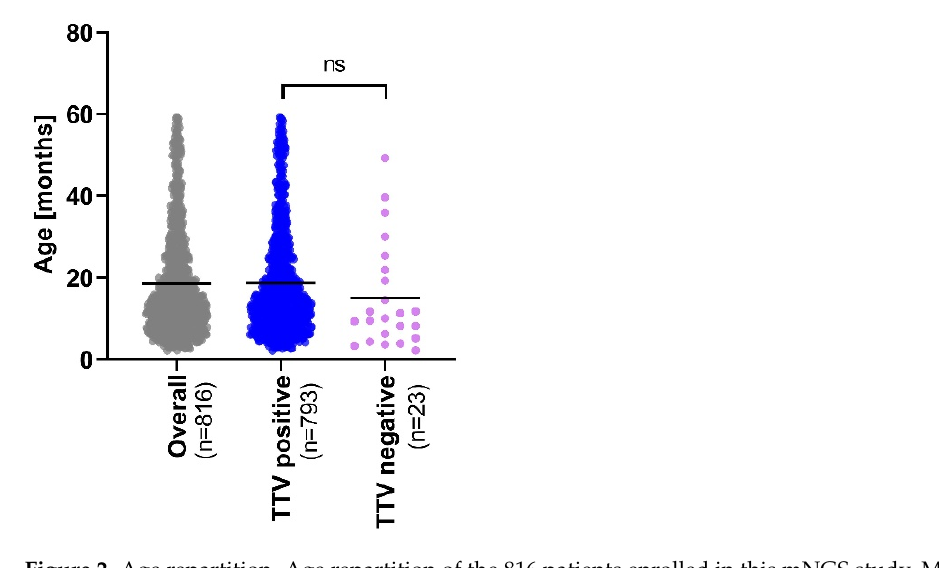
Figure 2. Age repartition. Age repartition of the 816 patients enrolled in this mNGS study. Medians are reported by black bars. Unpaired t-test was used to compare means. ns,